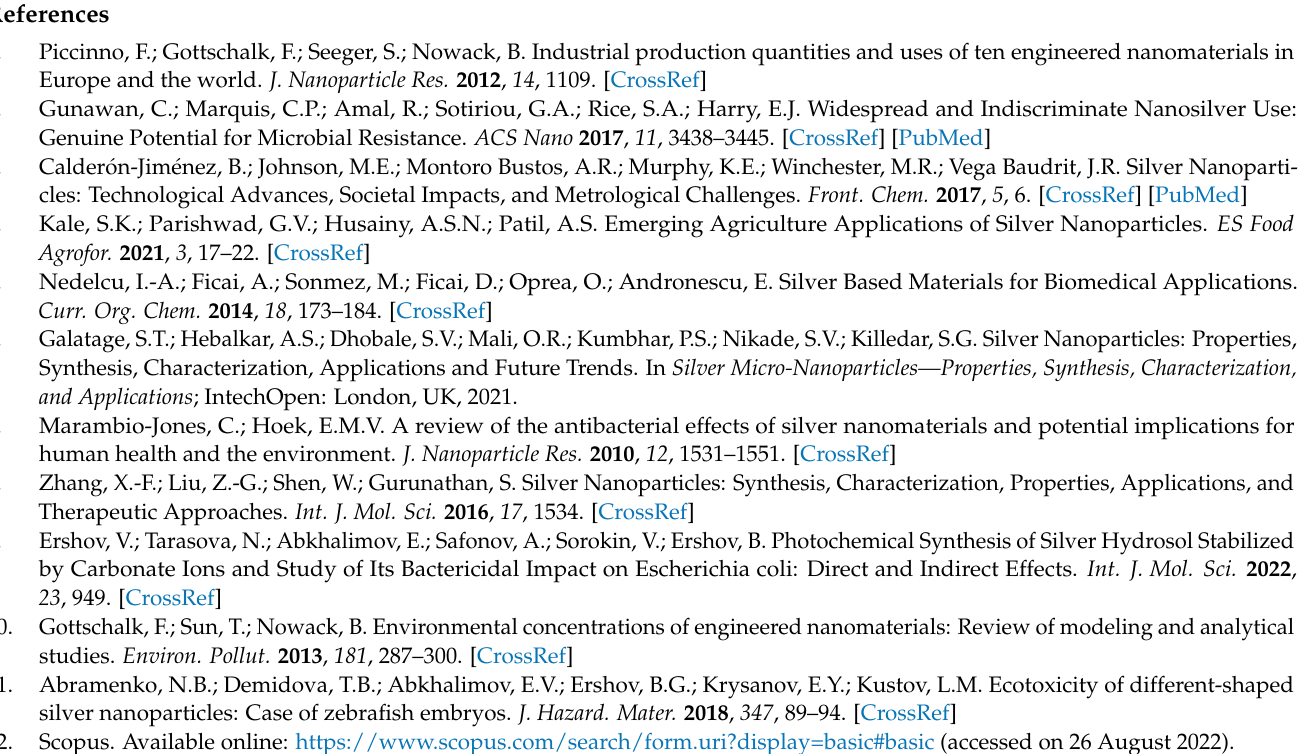
Figure S2: Size distribution of carbonate silver NPs; Figure S3: Size distribution of silver nanoplates; Figure S4: TEM (a) and HRTEM (b) images of polyphosphate NPs; FFT images of the area highlighted by the square in Figure S4a (c); Lattice fringes obtained from Figure S4c by inverse FFT (d); Profile of d-spacing of the area highlighted in Figure S4d (e); Figure S5: TEM (a) and HRTEM (b) images of carbonate NPs; FFT images of the area highlighted by the square Figure S5a (c); Lattice fringes obtained from Figure S5c by inverse FFT (d); Profile of d-spacing of the area highlighted in Figure S5d (e); Figure S6. XRD pattern of carbonate